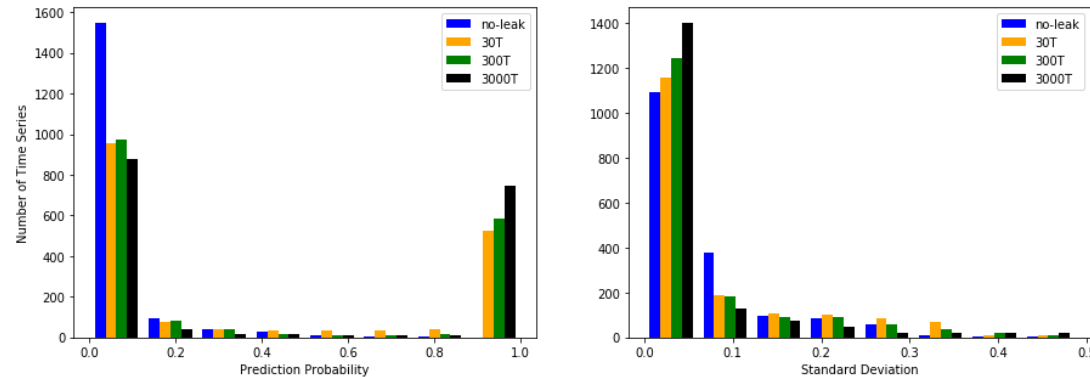
Figure 5. ( Left Panel ) Prediction probability for each scenario plotted as a histogram. ( Right Panel ) Standard deviation for each scenario plotted as a histogram. The central observation is that most of the time series is classified as either leak = 0 or No-leak = 1. Minor leaks have a smaller proportion of the time series that are classified as leaks than larger ones and smaller leaks are associated with a higher degree of uncertainty than the larger ones.